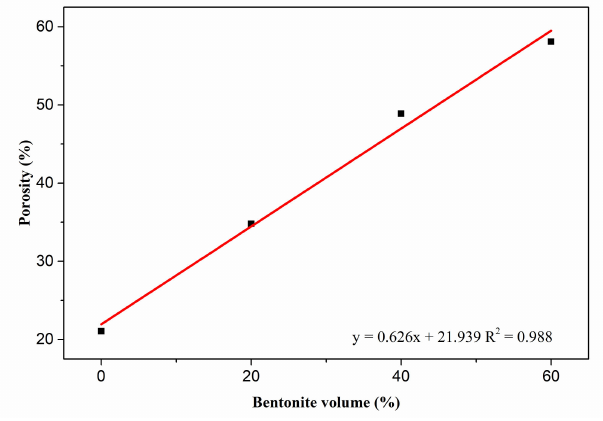
Figure 7. Porosity of porous MOS cement paste.